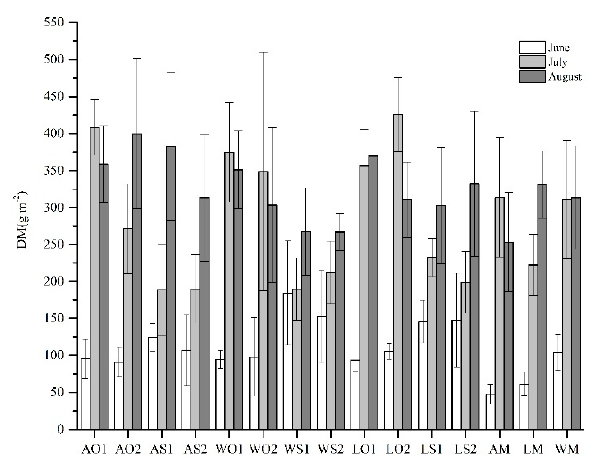
Figure A2. The DM among all treatments during the growing season (mean ± SD). The abbreviations are the same as above.